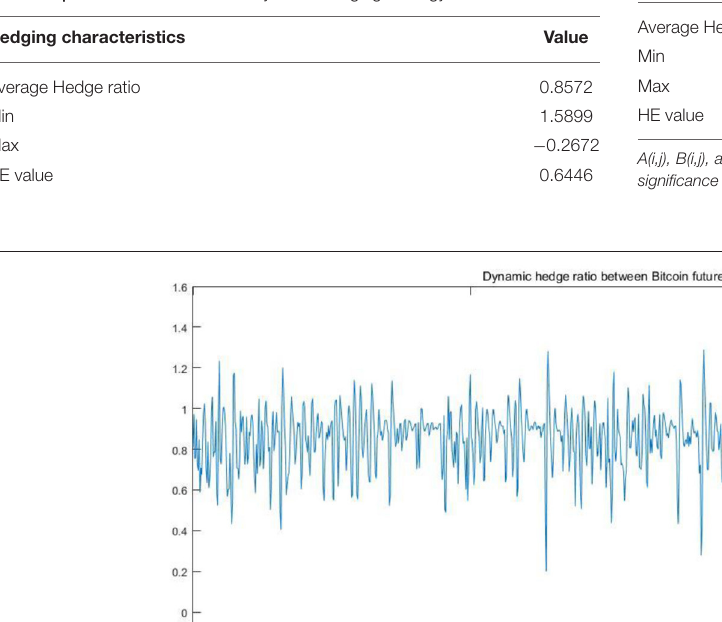
TABLE 5 | Basic information of the dynamic hedging strategy.